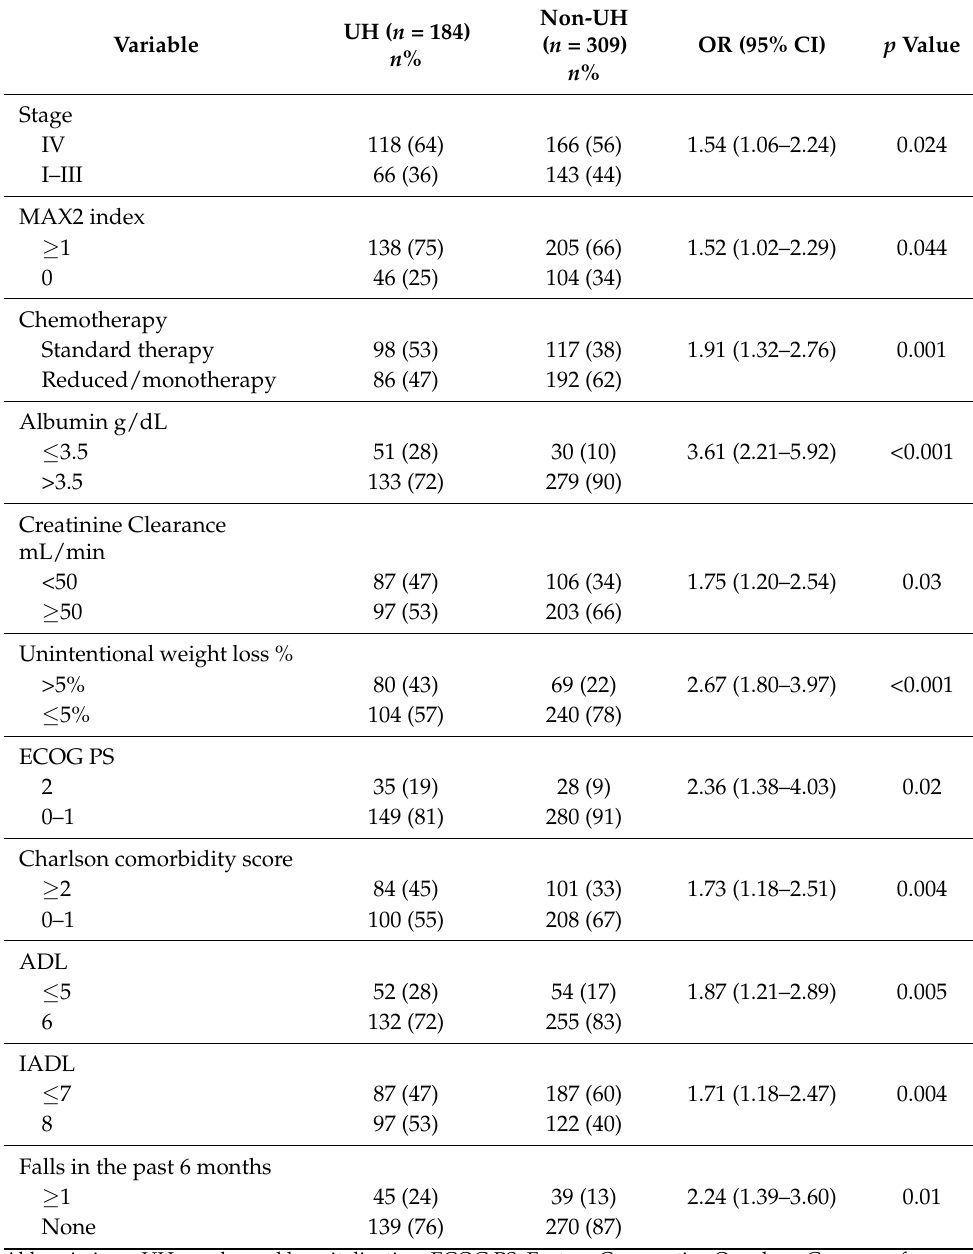
Table 3. Factors associated with unplanned hospitalizations on univariable